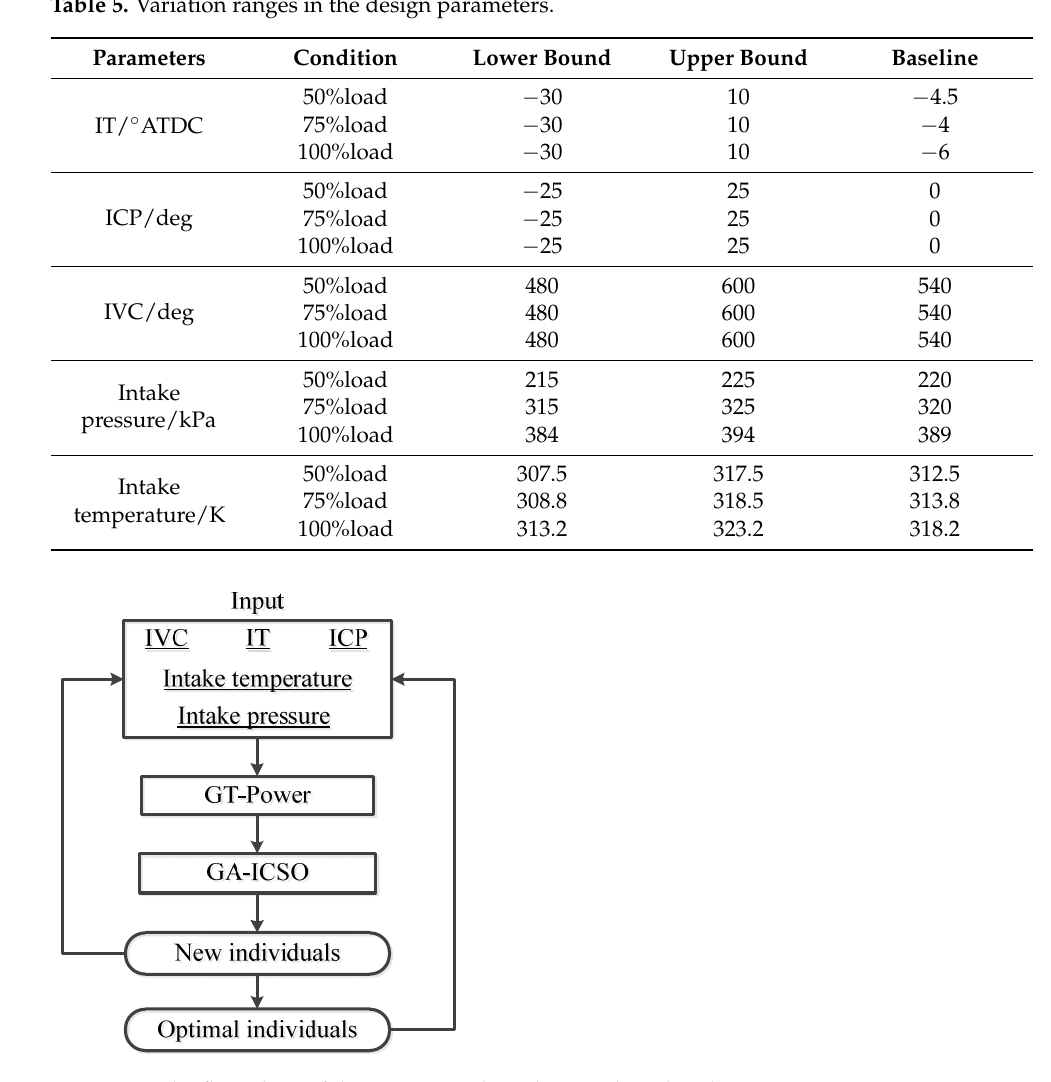
Figure 10. The flow chart of the GA-ICSO algorithm combined with GT-Power.